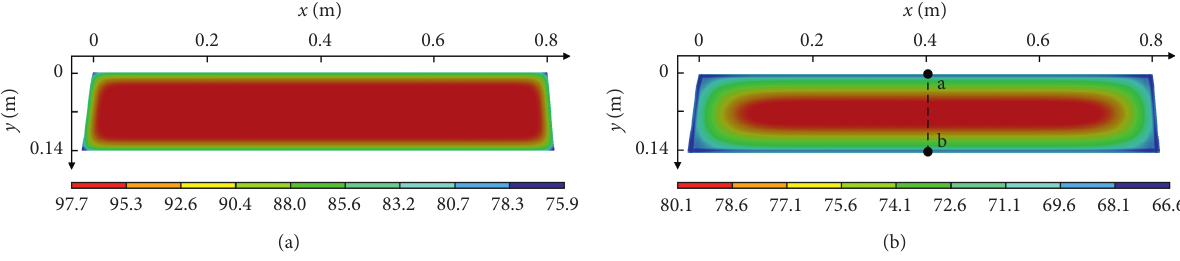
Figure 14: RH contour of sleeper at different times. (a) t � 1d and (b) t � 60 d.